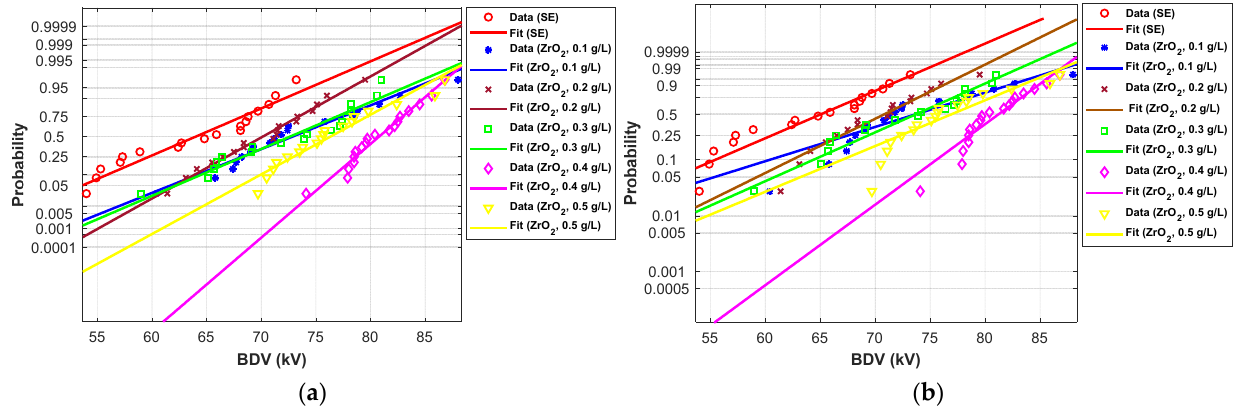
Figure 13. Probability plot of breakdown voltage data of SE-based nanofluids with ZrO 2 (20–30 nm) for the 2 mm electrode gap; ( a ) normal and ( b ) extreme value.